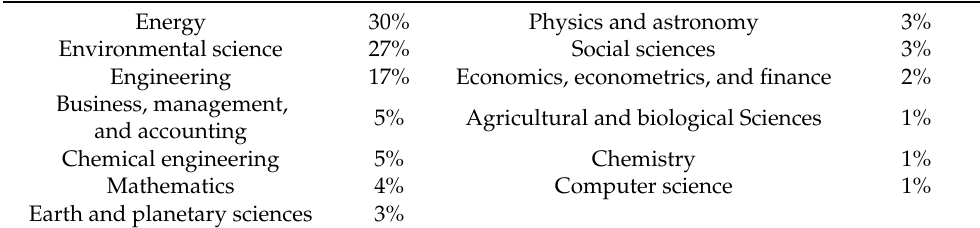
Table 4. Subject areas in the selected publications.